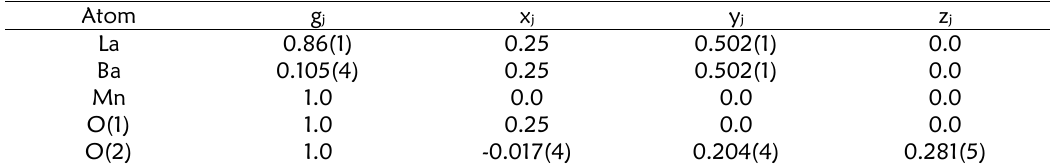
Table 2. The coordinates of atomic fractions (x j , y j , z j ), and atomic occupancy factor (g j ) of S1 sample.